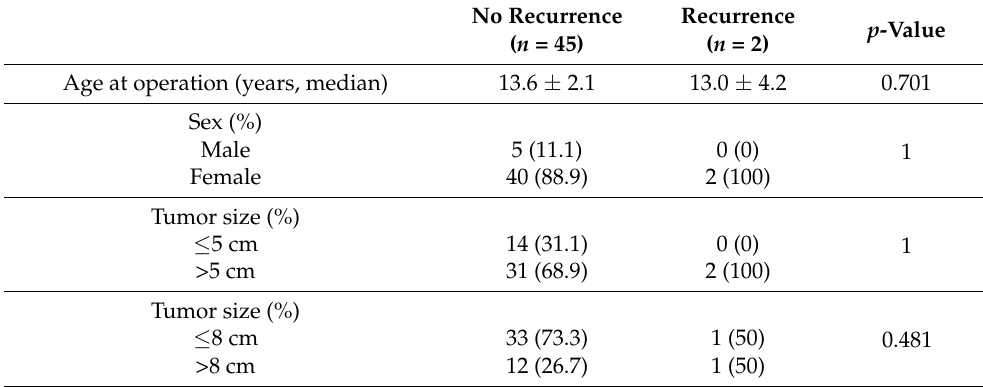
Table 2. Clinical factors associated with